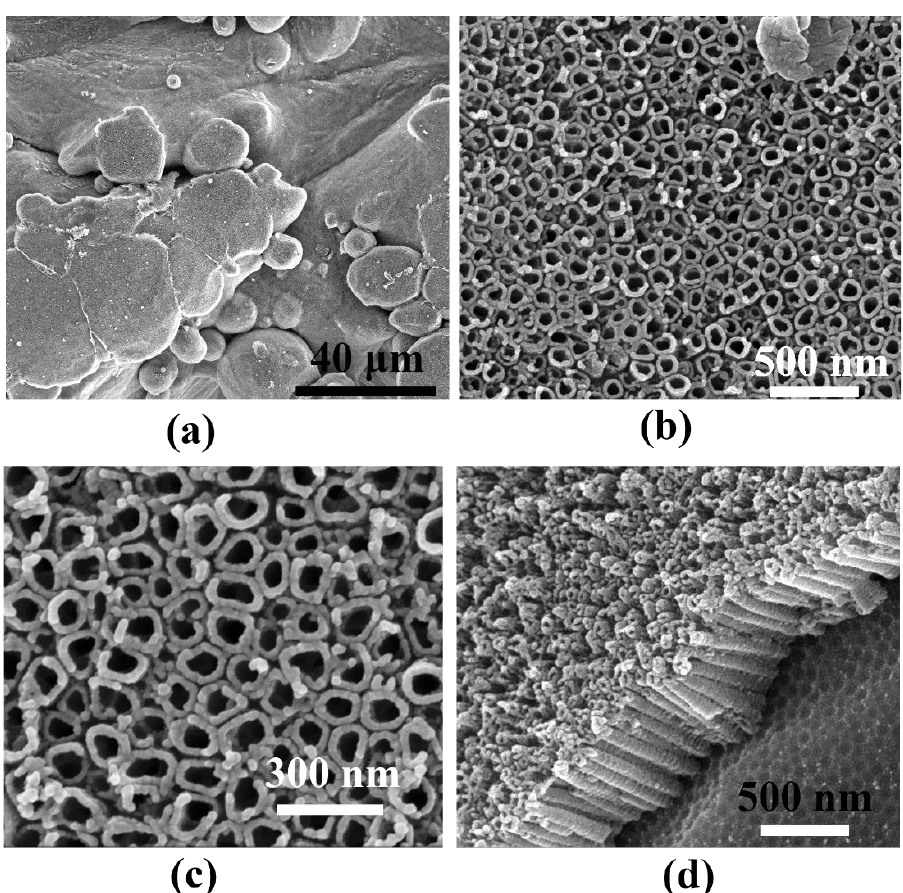
Figure 5. SEM images of Ti 3D surface after anodic oxidation and silver deposition by magnetron sputtering (0.02 mg/cm 2 ). Magnification of images is: ( a ) 1000×, ( b ) 50,000× and ( c ) 100,000×. Side view of TiO 2 NTs with silver deposit ( d ).